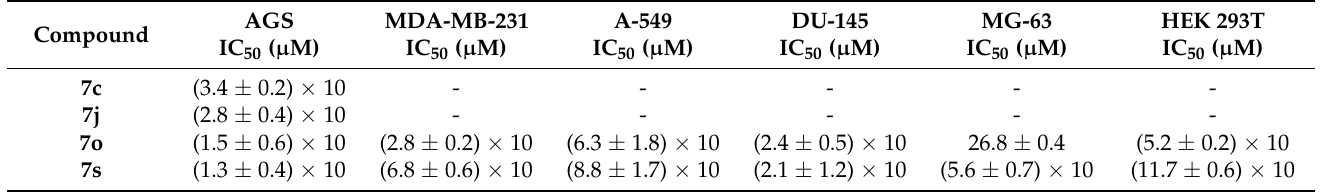
Table 3. IC 50 values 1 in cancer cell lines of selected compounds.